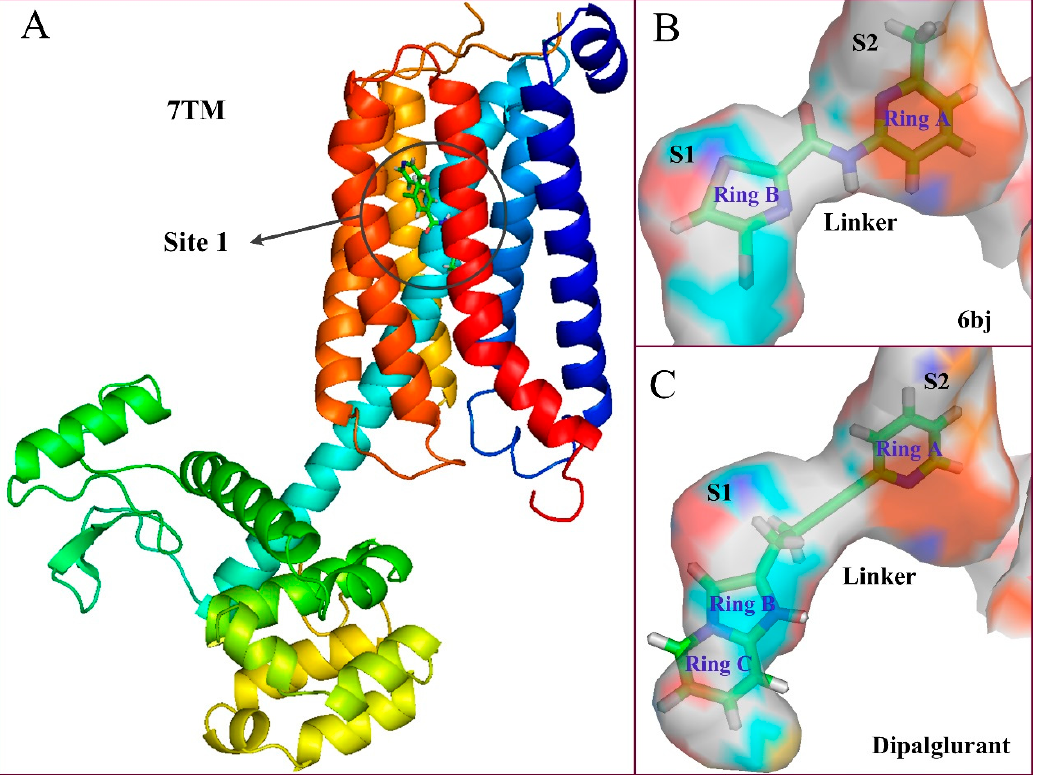
Figure 11. ( A ) NAMs’ binding Site 1. ( B ) The cavity structure of compound 6bj at Site 1. ( C ) The cavity structure of compound Dipalglurant at Site 1.